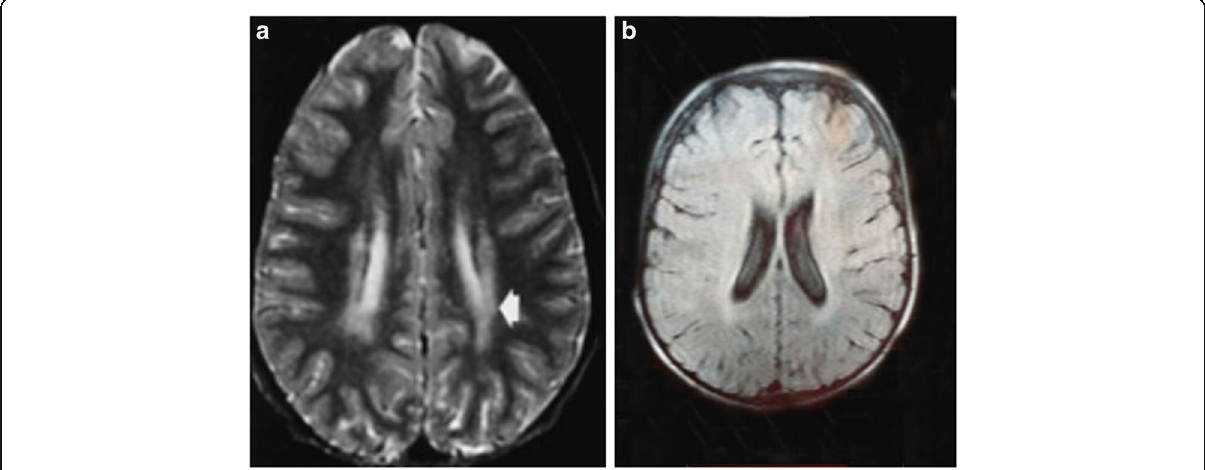
Fig. 1 MRI report of patient I. a mild abnormal signal changes in periventricular white matter, b mild abnormal signal changes in periventricular white matter in T1